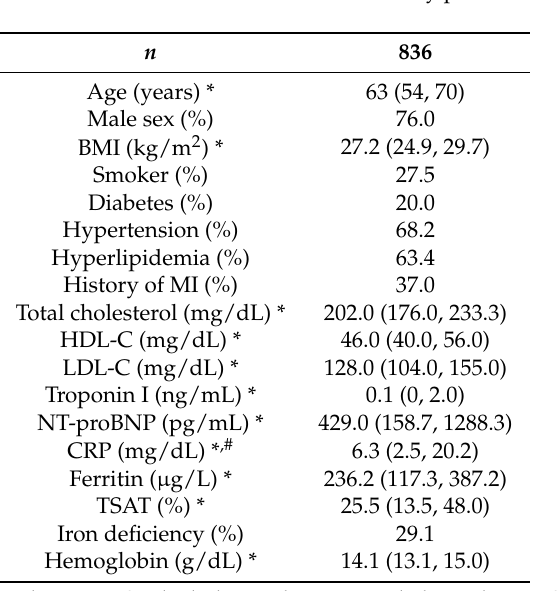
Table 1. Baseline characteristics of the study